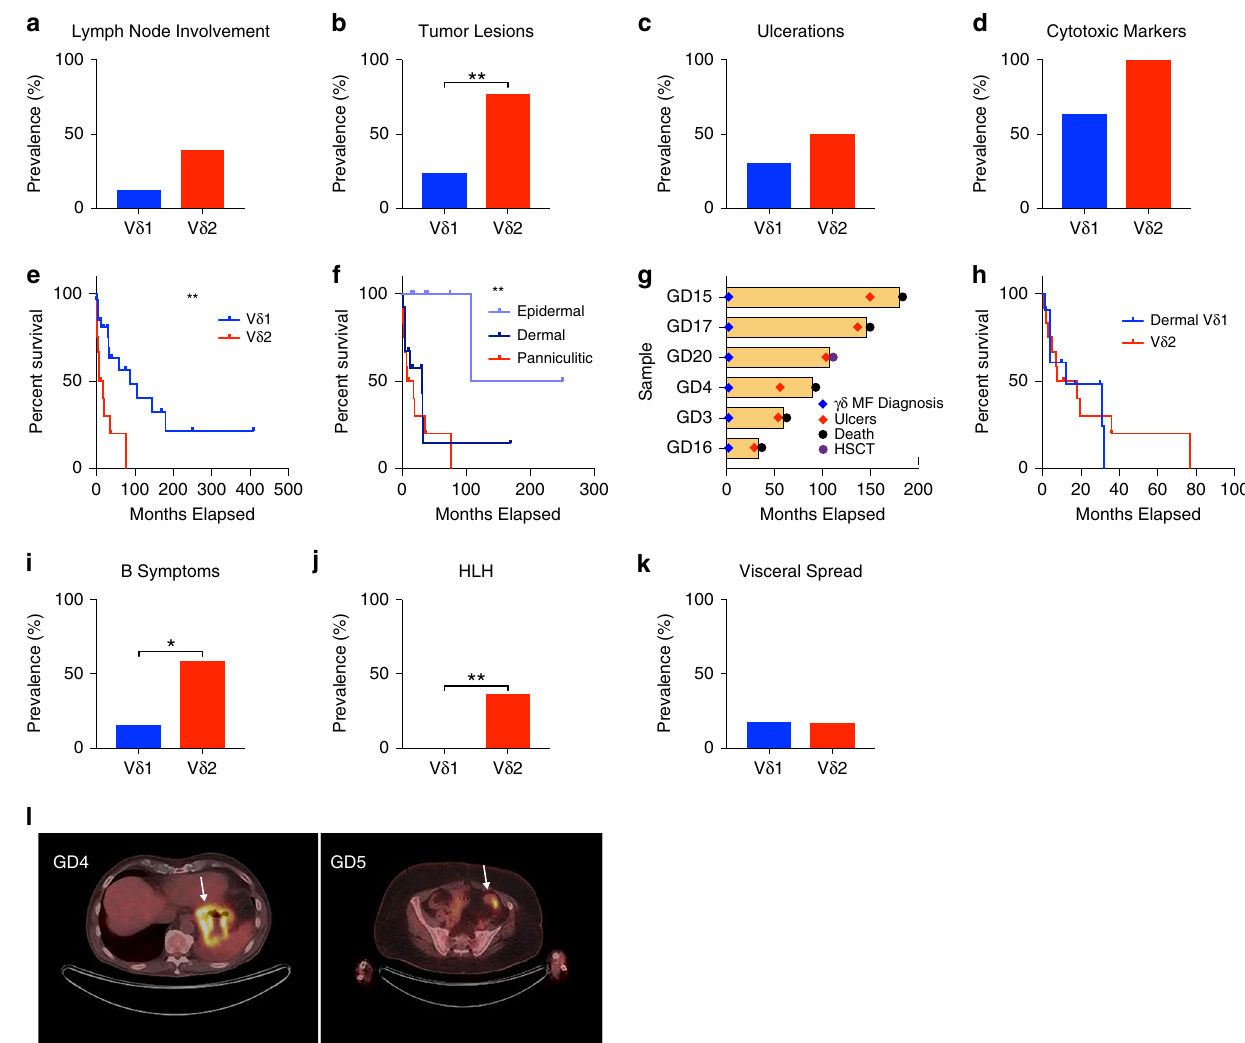
Fig. 3 Cell of origin and histologic subtype in fl uences clinical phenotypes in CGDTL. a , b Prevalence in patients with V δ 1 or V δ 2 disease of lymph node involvement (V δ 1 n = 24; V δ 2 n = 10) and tumor stage skin lesions (V δ 1 n = 25; V δ 2 n = 13) at diagnosis, respectively. c , d Prevalence of ulcerated skin lesions (V δ 1 n = 26; V δ 2 n = 12) and cytotoxic marker staining (V δ 1 n = 22; V δ 2 n = 9), respectively, based on cell of origin. e Kaplan – Meier curves of patients with V δ 1 ( n = 27) or V δ 2 ( n = 12) lymphomas. f Kaplan – Meier curve based on depth of disease in the diagnostic biopsy specimen (epidermal n = 9; dermal n = 13; panniculitic n = 12). g Swimmer ’ s plot highlighting disease course of Mycosis-fungoides like cases that acquire an ulcerative phenotype ( n = 6). HSCT, hematopoietic stem cell transplant. h Kaplan – Meier survival curve for patients with dermal V δ 1 lymphomas ( n = 11; excluding γδ MF cases) and V δ 2 lymphomas ( n = 12). i – k Frequency of B symptoms (V δ 1 n = 26; V δ 2 n = 12), hemophagocytic lymphohistiocytosis (HLH) (V δ 1 n = 25; V δ 2 n = 11), and visceral spread (V δ 1 n = 28, V δ 2 n = 12), respectively, among patients with V δ 1 or V δ 2 disease. l Images of positron emission tomography – computed tomography from two patients with V δ 1 lymphomas with spread to the gastrointestinal tract. White arrows highlight areas of increased signal; stomach (GD4) and large intestine (GD5). For e, f ** indicates P value <0.005, log-rank test. For b , i , j *indicates P value <0.05, and **indicates P value <0.005, two-sided Fisher ’ s exact test. Source data are provided as a source data fi